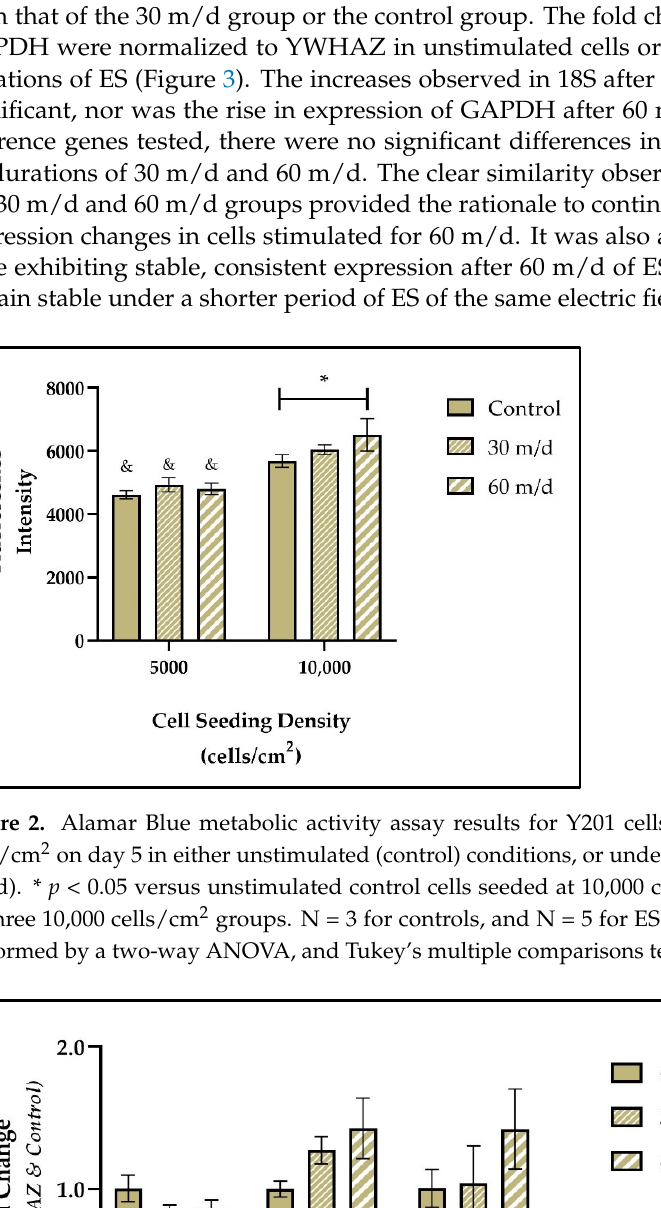
Figure 3. Gene expression of PPIA, 18S, and GAPDH normalized to YWHAZ and the unstimulated control group in Y201 cells under ES regimes of 30 and 60 min per day (m/d) at a seeding density of 10,000 cells/cm 2 . N = 2 for controls and n = 3 for both 30 m/d and 60 m/d ES groups. Statistical analysis performed by a two-way ANOVA for each gene, and Tukey’s multiple comparisons